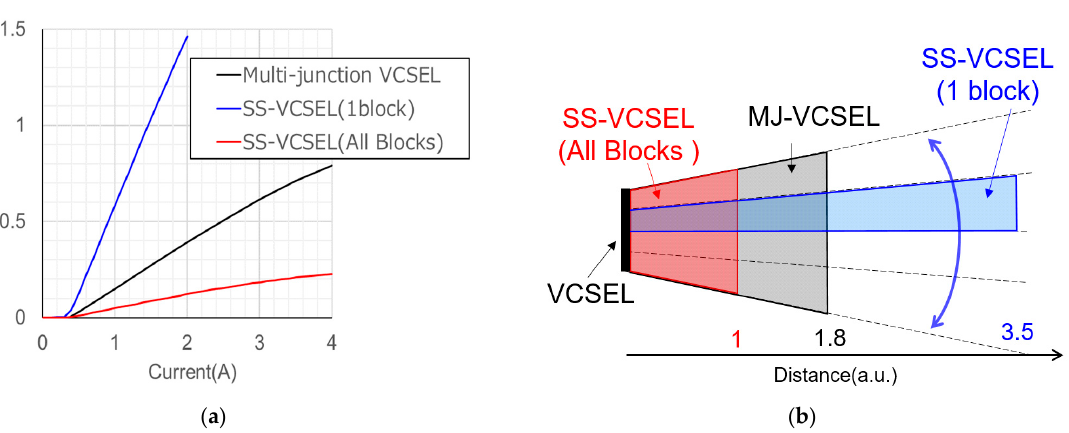
Figure 13. ( a ) Comparison between current–optical power density characteristics of a conventional three-junction VCSEL array with approximately 500 emitters and an SS-VCSEL with a single-junction active layer under one-block and all-blocks emissions. ( b ) Schematic of the measurement distances of the devices.